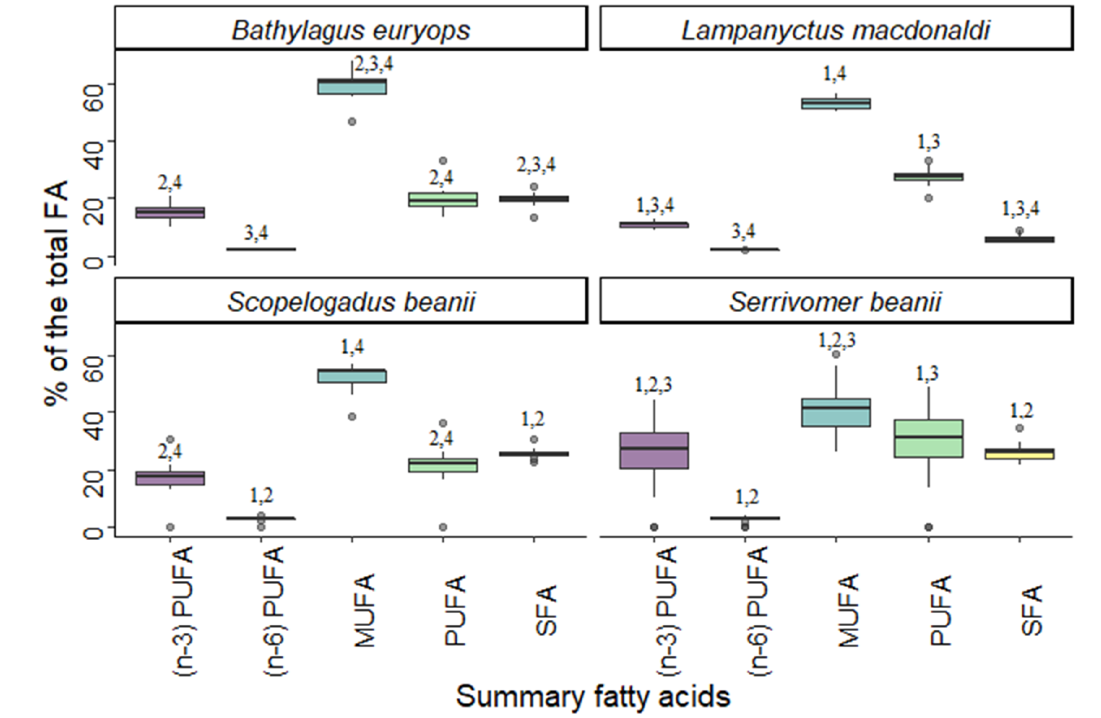
Figure 9. Certain FA classes (% of the total FAs) in muscles of mesopelagic fish species (